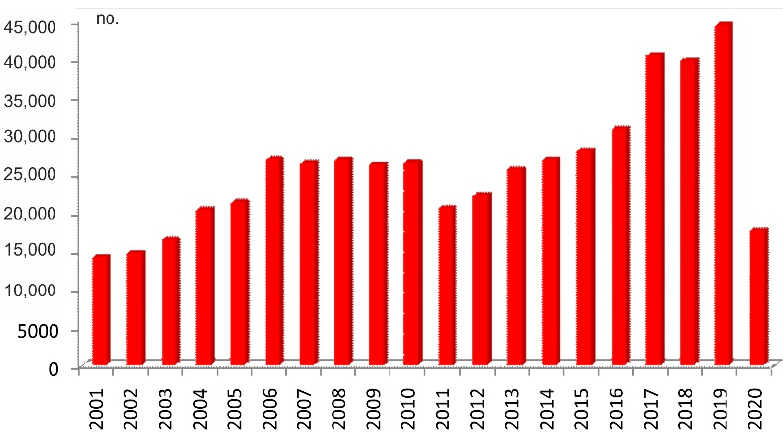
Figure 3. Tourist overnight stays in the reception structures providing accommodation (Data source: National Institute of Statistics, TEMPO Online).